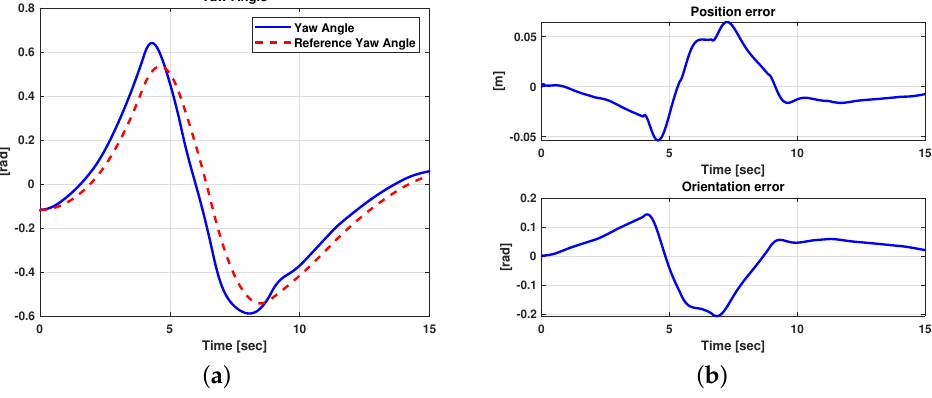
Figure 19. Simulation scenario 2: comparison between reference and measured yaw angles ( a ) and position and orientation errors ( b